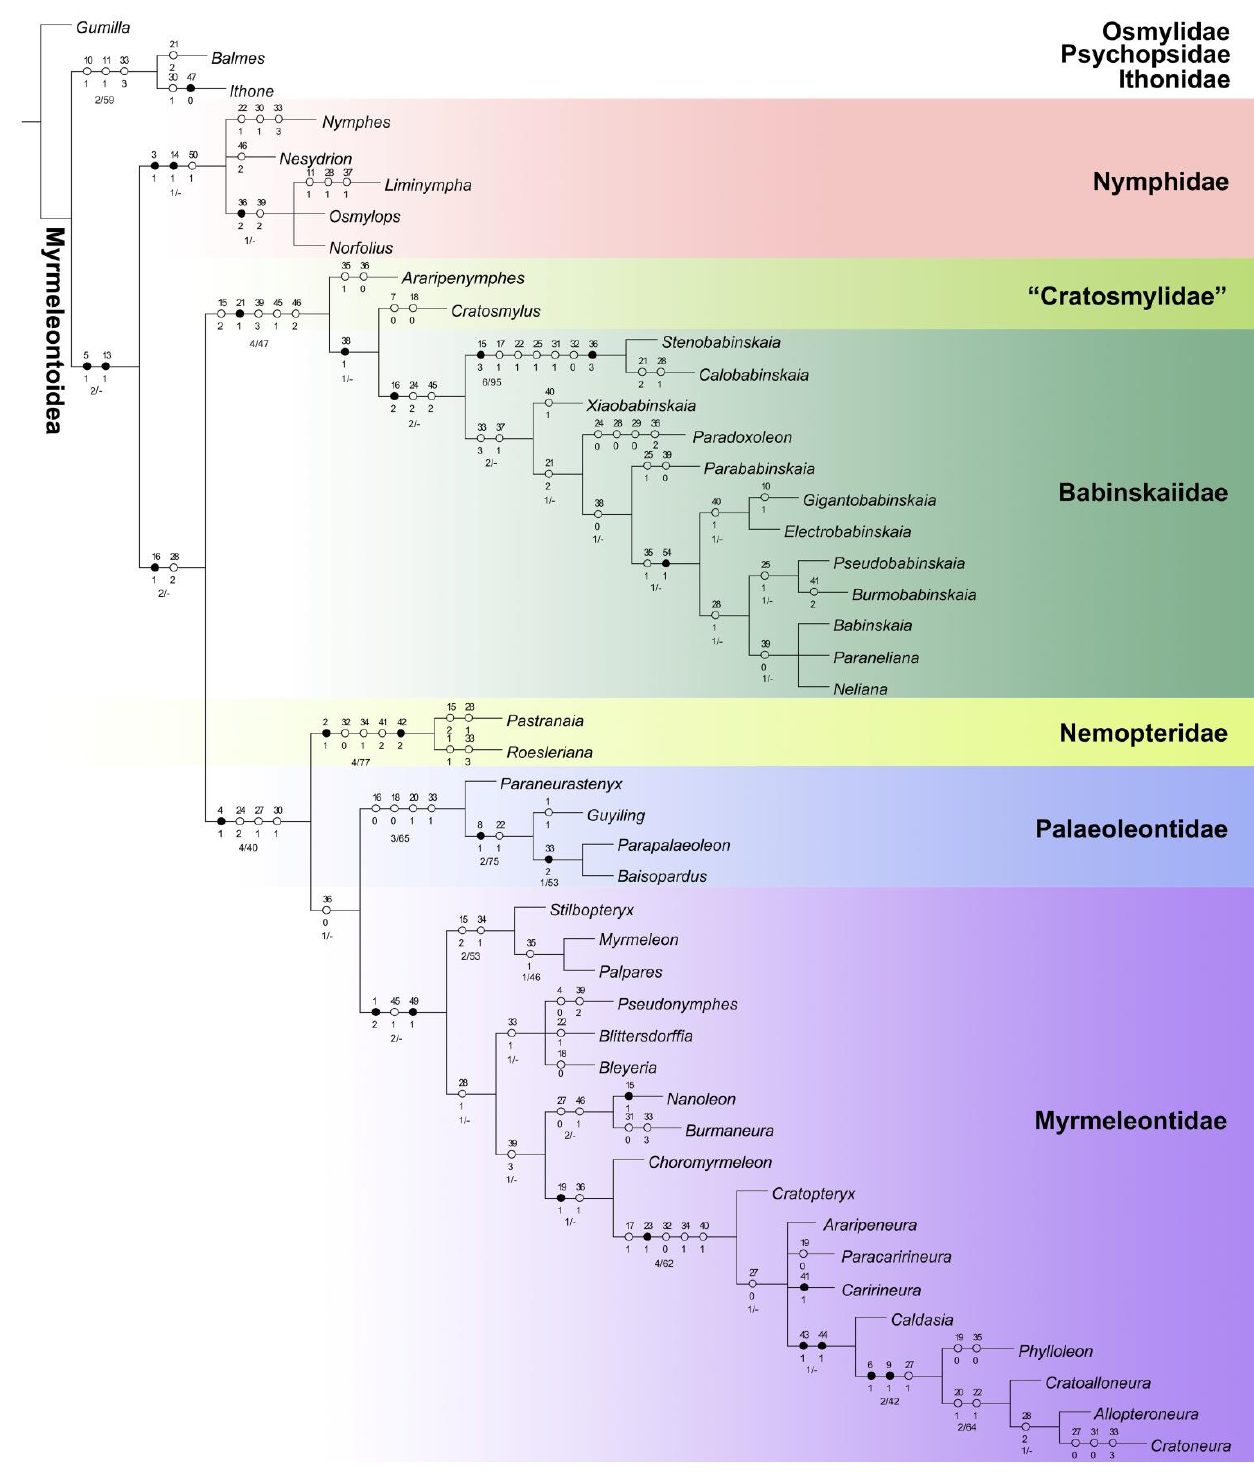
Figure 4. Phylogeny and evolutionary chronogram of extinct and extant Myrmeleontoidea. Topology represents the strict consensus tree of the two most parsimonious trees yielded from TNT. Unambiguous state changes of the morphological characters at the familial and higher level are shown on the tree. Black circle represents the homologous state and white circle represents the homoplasious state. Bremer support values/bootstrap values are shown at relevant nodes.